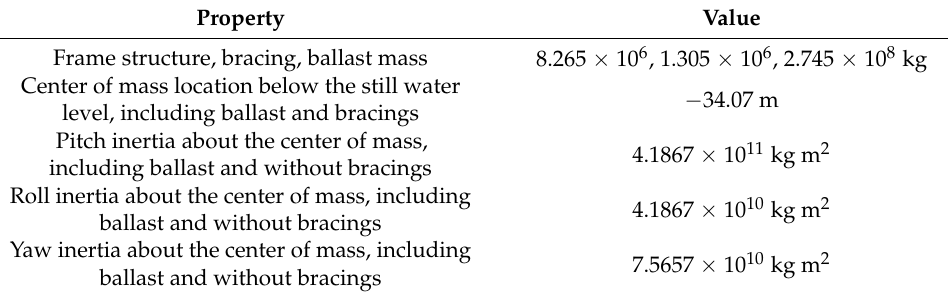
Table 2. Structural properties of the fishing cage.